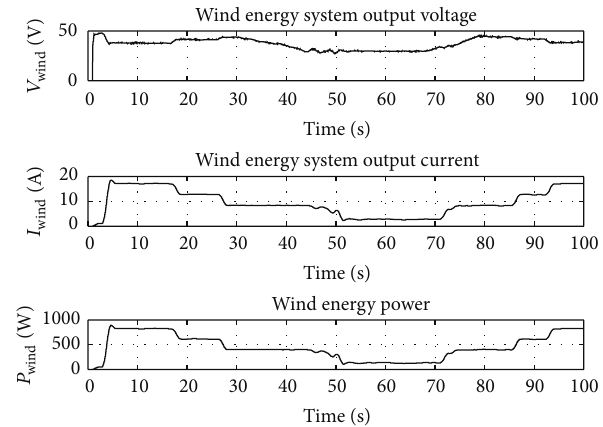
Figure 28: Current, voltage, and power changes of wind energy system.